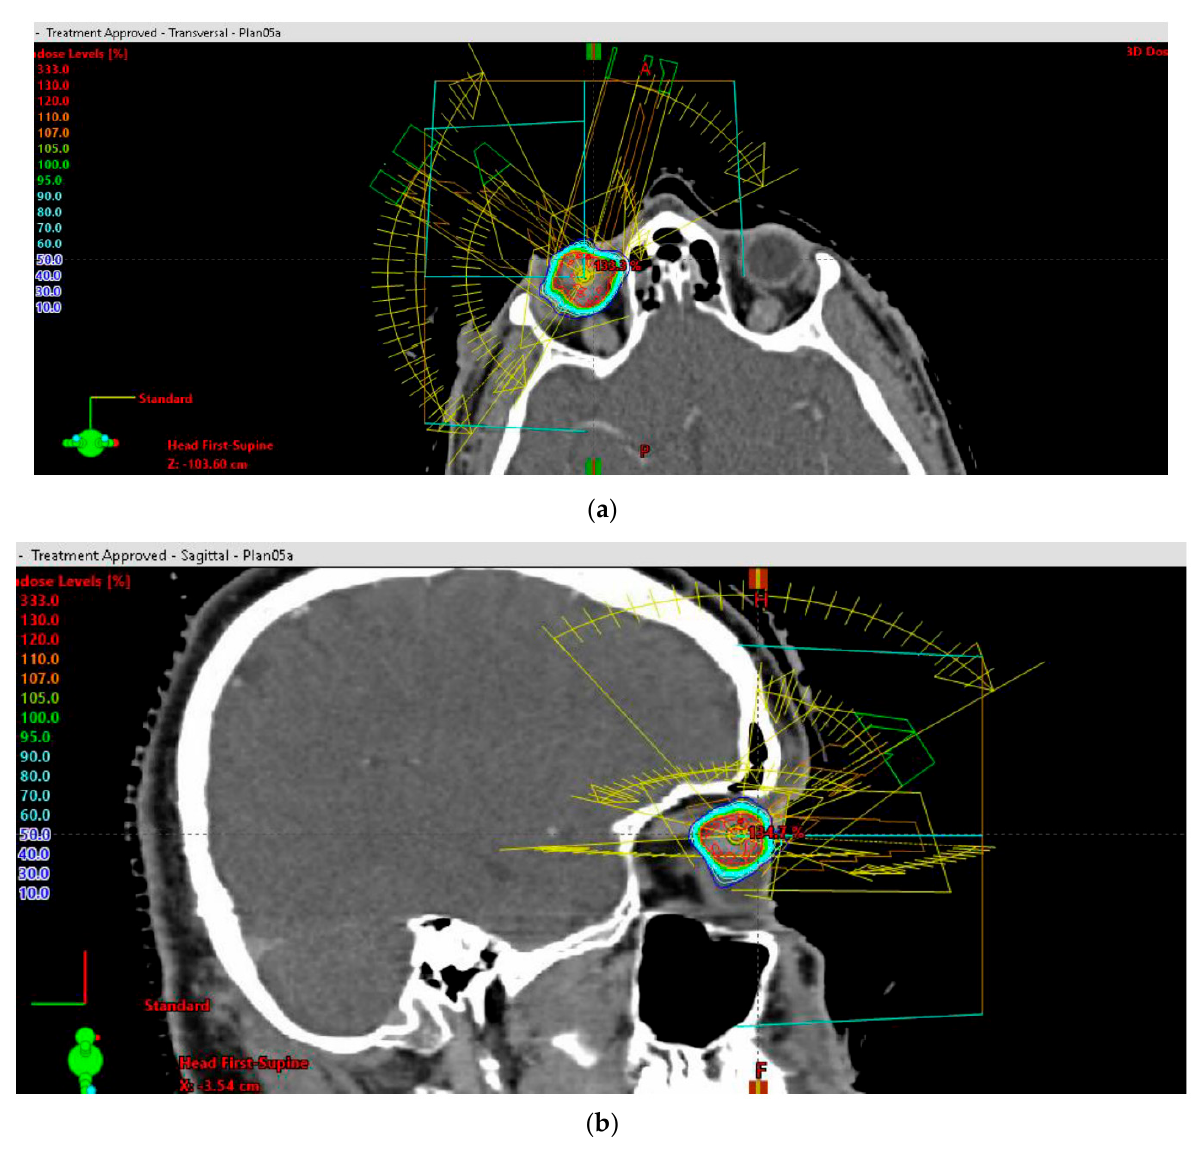
Figure 3. ( a ) Stereotactic radiosurgery (SRS) by image-guided (IG) volumetric modulated arc therapy (VMAT) for patients with unfavorable-risk, large intraocular melanoma: representative 3D beam arrangements—axial plane. ( b ) Stereotactic radiosurgery (SRS) by image-guided (IG) volumetric modulated arc therapy (VMAT) for patients with unfavorable-risk, large intraocular melanoma: representative 3D beam arrangements—sagittal plane.